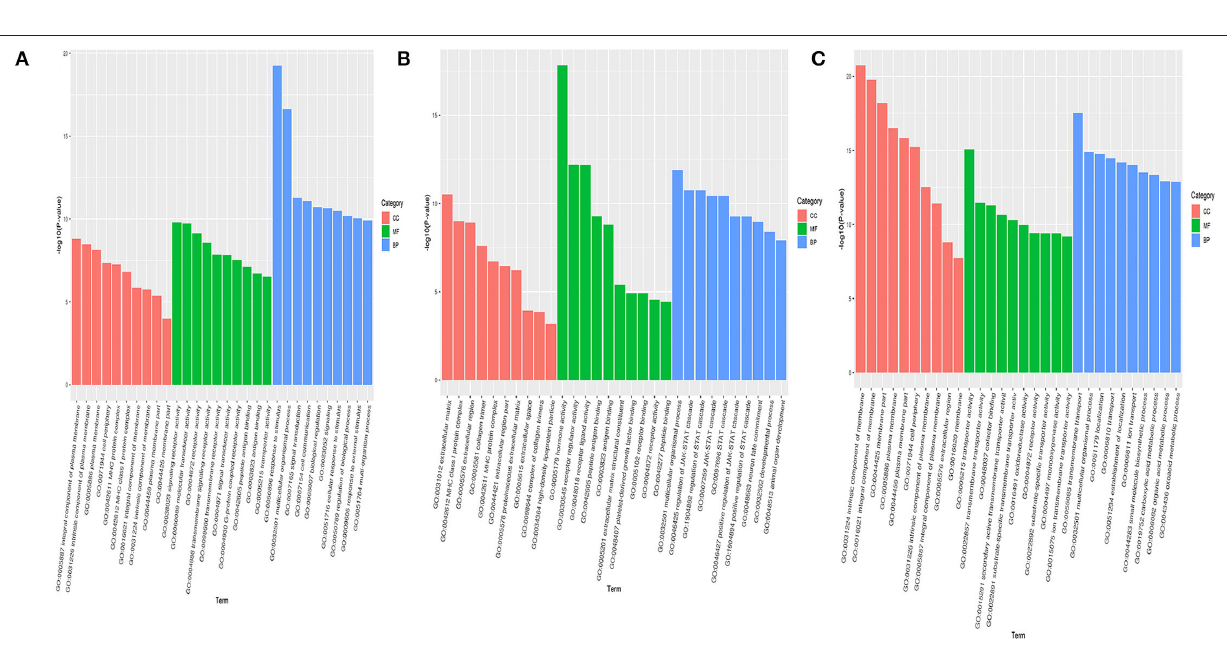
FIGURE 4 | Hypothalamus, pituitary, ovary of GO enrichment analysis of differentially expressed genes in Zi-goose. Note: the abscissa is the term of Go level 2 grade, and the ordinate is the –log 10 ( P -value) enriched for each term. (A–C) represent the results of GO enrichment analysis of differentially expressed genes in hypothalamus, pituitary, ovary of